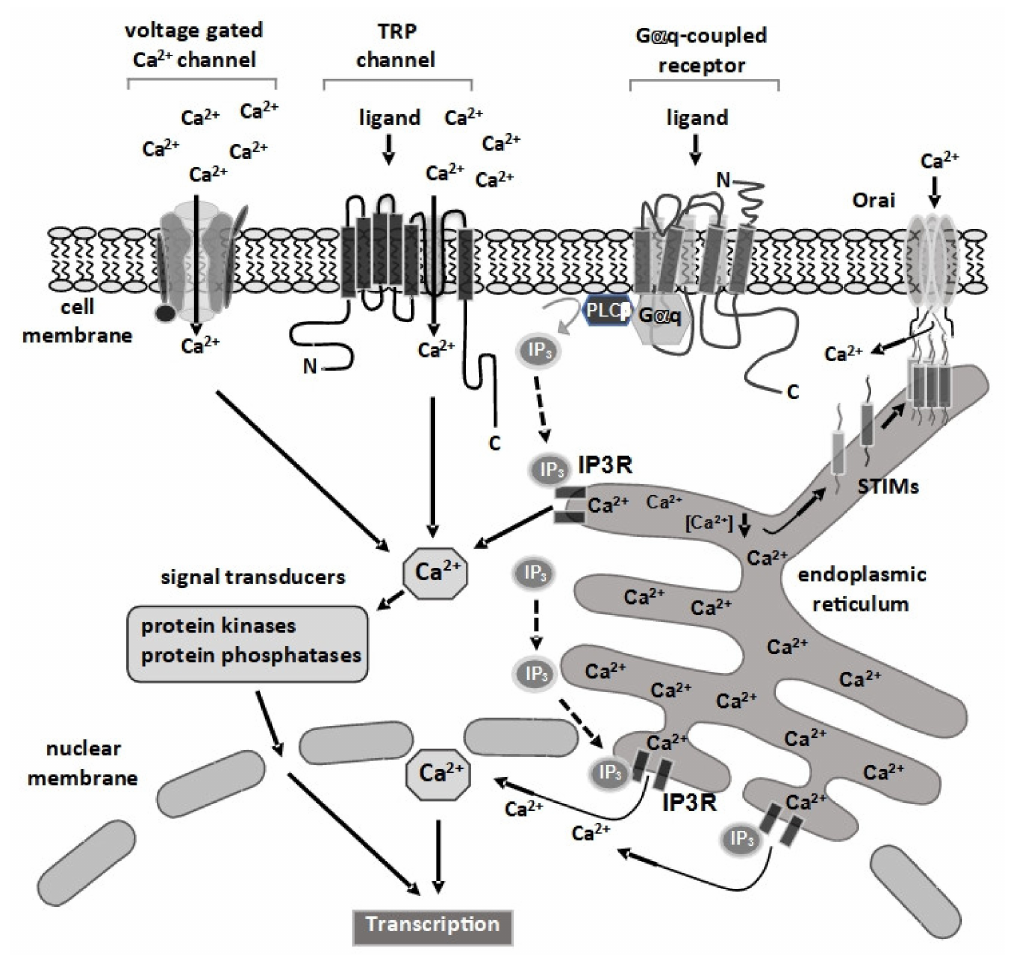
Figure 1. Stimulation of cell surface receptors and channels increases the intracellular Ca 2+ concentration. Cells express a variety of Ca 2+ channels at the plasma membrane, including voltage-gated Ca 2+ channels and ligand-regulated TRP channels. Stimulation of G α q-coupled receptors activates phospholipase C β , leading to the generation of inositol-1,4,5- trisphosphate (IP 3 ) and diacylglycerol. IP 3 is a ligand for the ionotropic IP 3 receptor, located in the membrane of the endoplasmic reticulum (ER), and binding triggers the influx of Ca 2+ from the ER store into the cytosol. The depletion of the Ca 2+ store of the ER is detected by the STIM proteins, Ca 2+ sensor proteins, that oligomerize and connect with the plasma membrane located Orai Ca 2+ channels. As a result, Ca 2+ ions flow into the cell. Since the ER is contiguous with the outer nuclear membrane, it has been proposed that IP 3 receptors are also expressed in the inner nuclear membrane, facing the nucleoplasm, and their presence allows the release of Ca 2+ directly into the nucleoplasm. Ca 2+ ions are second messengers that activate a variety of enzymes in the cytosol, including protein kinases and phosphatases that function as signal transducers. The information is transferred into the nucleus and triggers a change of gene transcription by activating stimulus-responsive transcription factors. Ca 2+ ions may also diffuse into the nucleus to regulate Ca 2+ -responsive enzymes and transcription